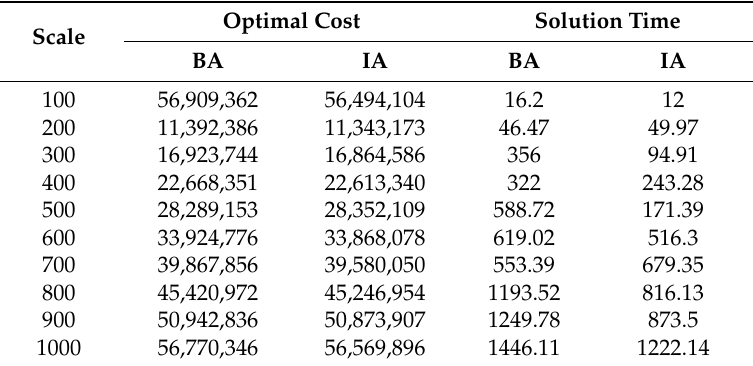
Table 3. Comparison of performance in large scale (gap: 2%).